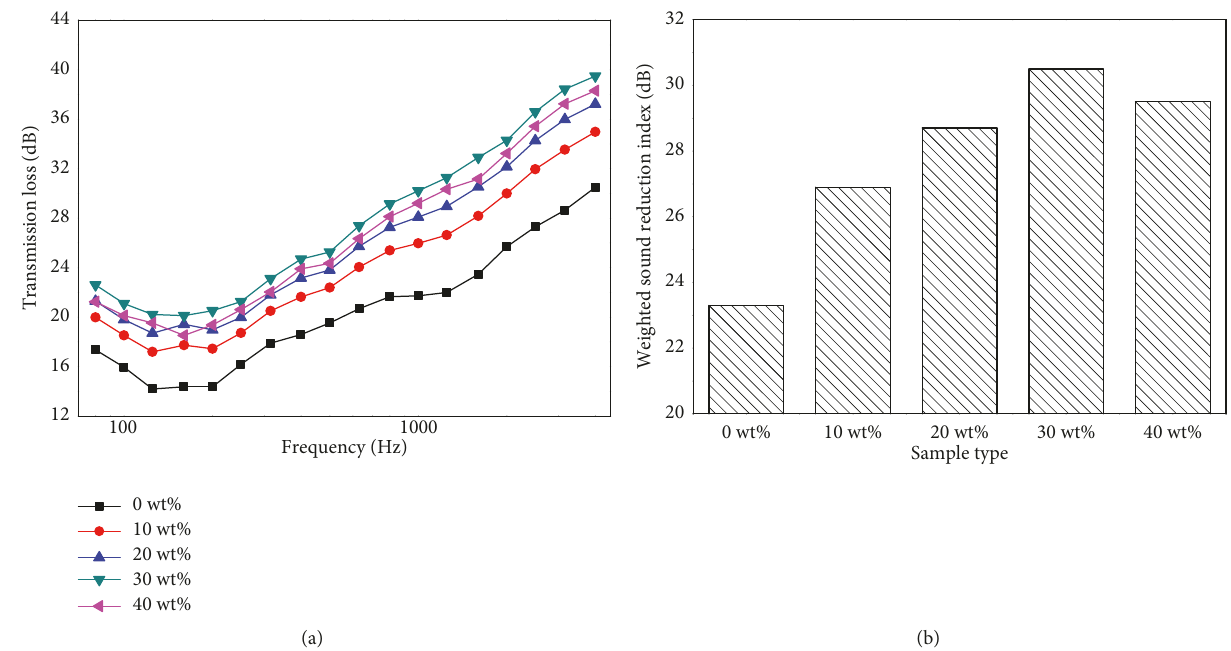
Figure 6: Sound insulation property of SFM/NBR-PVC microcellular foaming materials: (a) spectrum graph, (b) weighted sound insulation index histogram.